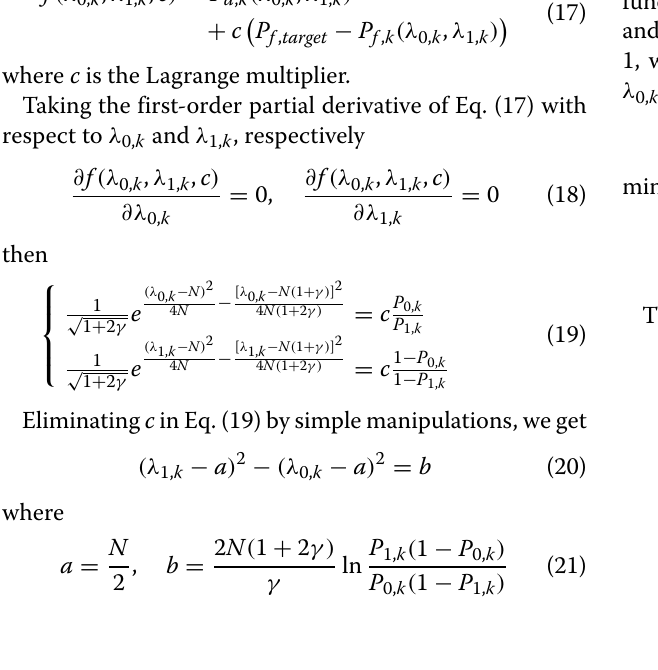
the optimal thresholds λ ∗ frame k is formulated as the optimization problem